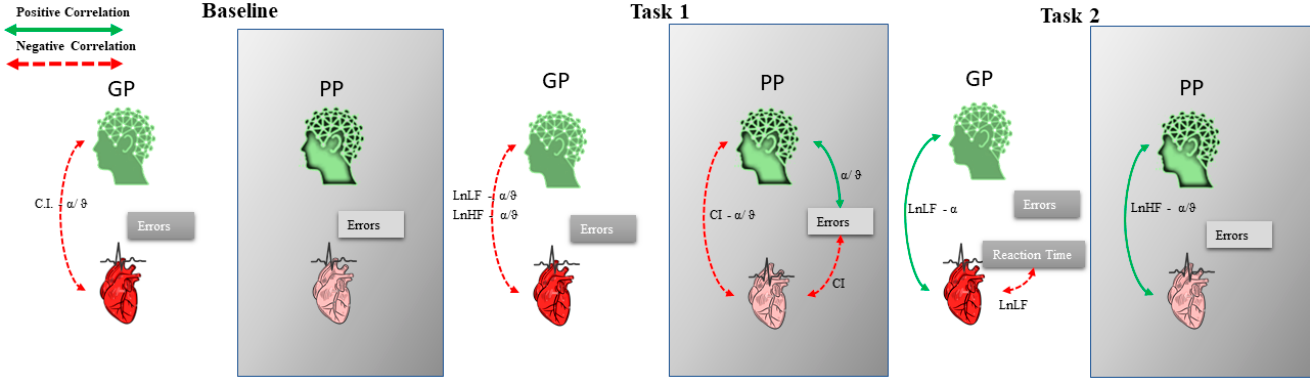
Figure 7. Correlation between HRV parameters (Complexity Index (CI), HF power (LnHF), LF power (LnLF)) and EEG α , ϑ , and α / ϑ ratio EEG powerbands of the group with Good Performance (GP) and of the group with Poor Performance (PP). Green and dashed red lines are the positive and negative correlations, respectively.